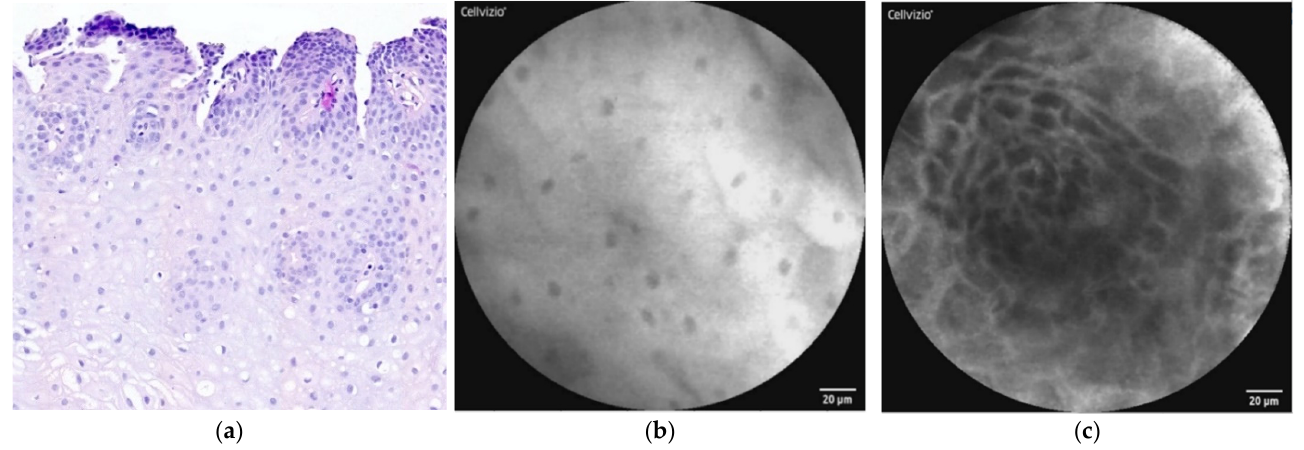
Figure 1. ( a ) Histopathology: image of stratified, nonkeratinizing squamous cell epithelium of distal esophagus with stromal papillae, hematoxylin–eosin staining. ( b , c ) pCLE view: squamous cells of esophageal epithelium ( b ) with stromal papillae ( c ).